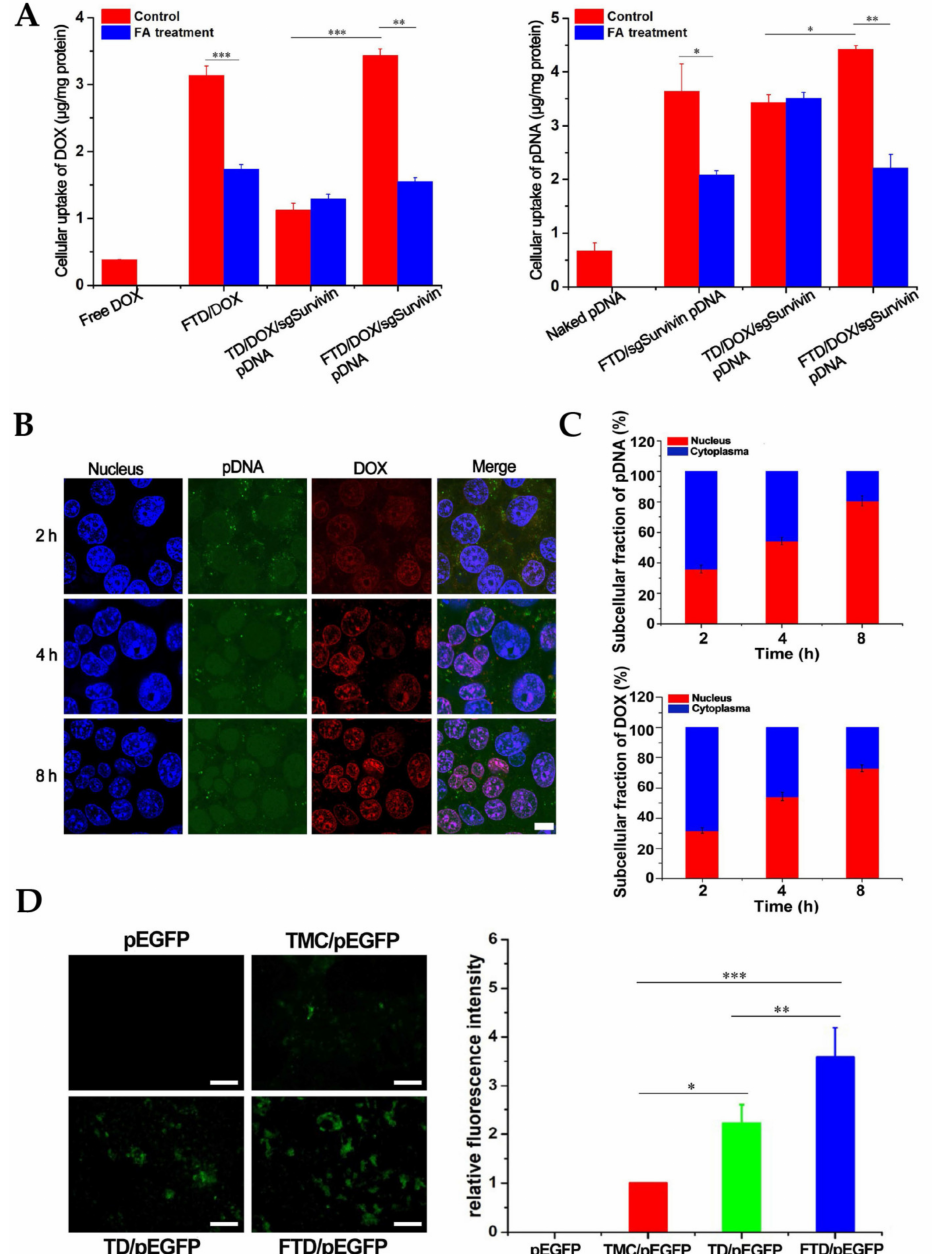
Figure 7. In vitro delivery efficacies of folic acid and 2-(Diisopropylamino) ethyl methacrylate dual- functionalized trimethyl chitosan nanoparticles (FTD NPs). ( A ) Cellular uptake of doxorubicin (DOX) and pDNA in 4T1 cells after 4 h incubation with NPs. Indicated values are mean ± SD ( n = 3). * p < 0.05, ** p < 0.01, *** p < 0.001. ( B ) CLSM images showing the nuclear transport of FITC-pDNA (green) and DOX (red) loaded into FTD NPs in 4T1 cells after 2, 4, and 8 h incubation. The nuclei were stained with Hoechst 33,258 (blue). Bar represents 10 µ m. ( C ) Intracellular distribution of DOX and pDNA in 4T1 cells following treatment with FTD/DOX/sgSurvivin pDNA NPs for 2, 4, and 8 h. Indicated values are mean ± SD ( n = 3). ( D ) Fluorescence microscope images and relative fluorescence intensity of pEGFP in 4T1 cells transfected for 48 h. Indicated values are mean ± SD ( n = 3). Bar represents 50 µ m. * p < 0.05, ** p < 0.01, *** p < 0.001. Source: reprinted from Li, Q.; Lv, X.; Tang, C.; Yin, C., Co-delivery of doxorubicin and CRISPR/Cas9 or RNAi-expressing plasmid by chitosan-based nanoparticle for cancer therapy. Carbohydrate Polymers 2022, 287, 119315 [151]. With permission from